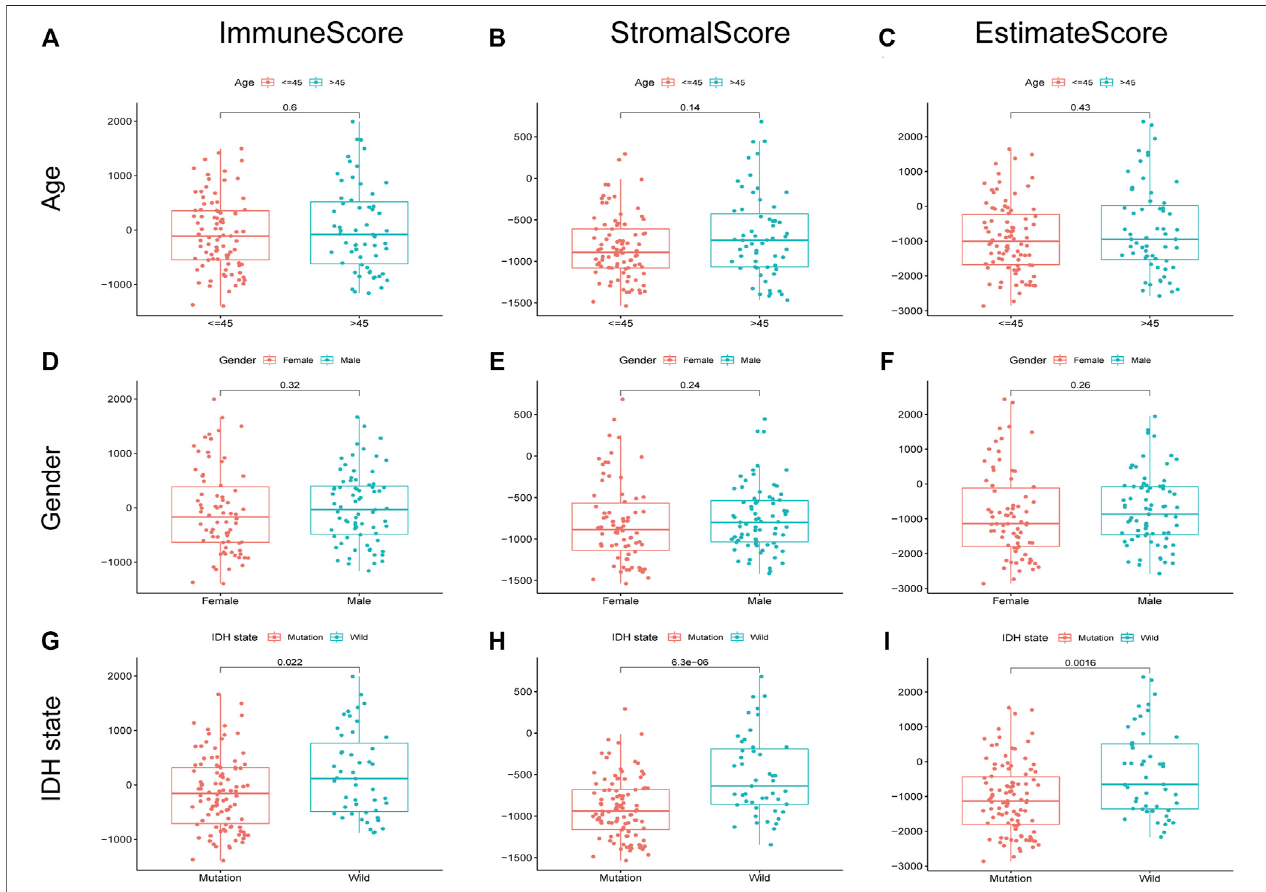
FIGURE 3 | Relationship between scores and clinical characteristics of LGG. immune score, stromal score, and ESTIMATE score were not signi fi cantly correlated with age (A – C) and gender (D – F) . The IDH state was signi fi cantly associated with immune score (G) , p = 0.022), stromal score (H) , p = 6.3e-06), and ESTIMATE score (I) , p =